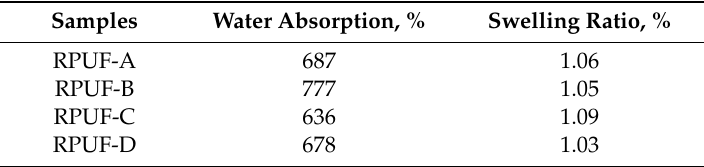
Table 4. Water absorption and swelling ratio of RPUF in di ff erent compositions.